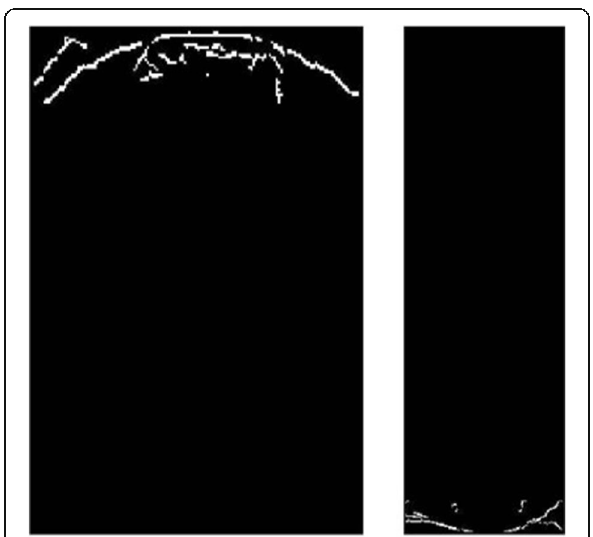
Fig. 5 Extended eye